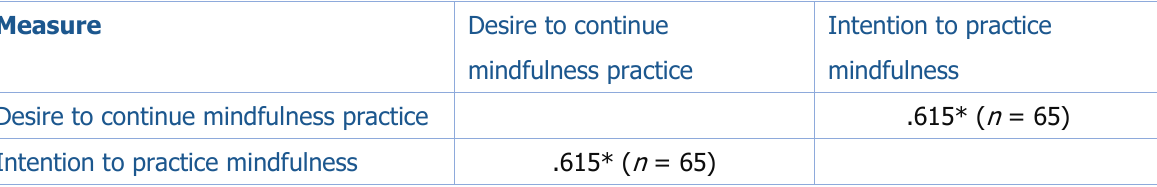
Table 7. Bivariate Correlation Between Desire to Continue Mindfulness Practice and Intention to Practice